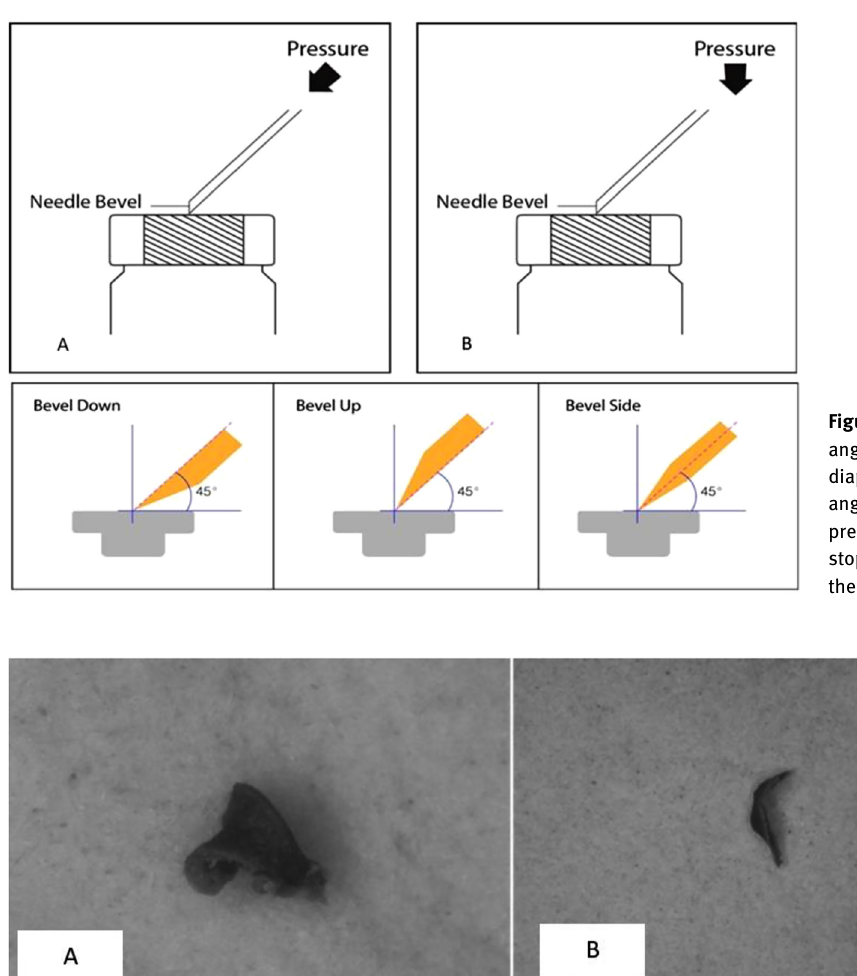
Figure 2: (A) core; (B) fragment (images viewed under 10 × eyepiece lens, 1 × objective lens, and zoomed 8 × for a total magni fi cation of 80 ×